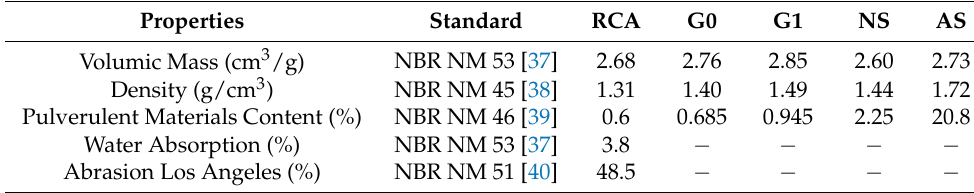
Figure 2. Particle size distribution of the aggregates. Table 2. Physical properties of the aggregates.